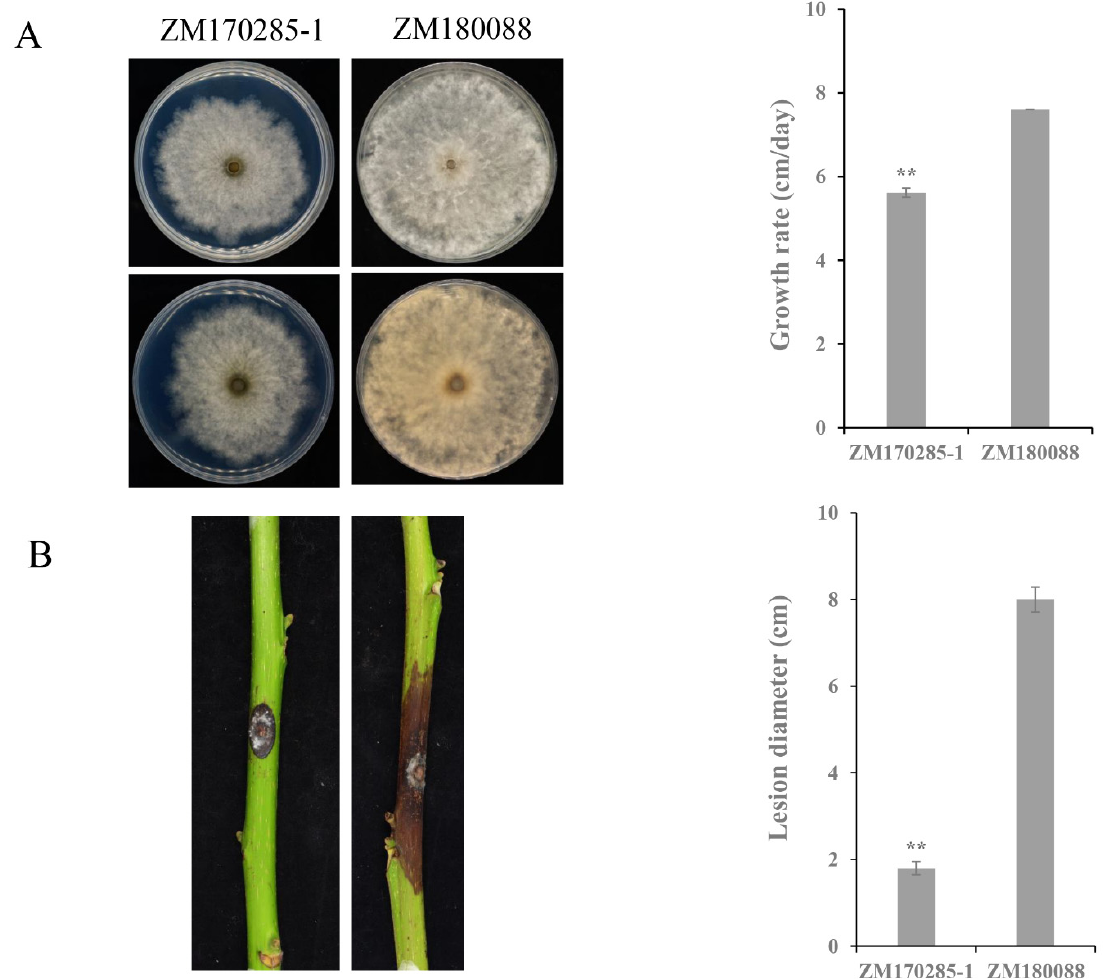
Figure 3. Biological characteristic comparison between strains ZM170285-1 and ZM180088. ( A ) Col- Biological characteristic comparison between strains ZM170285-1 and ony morphology and growth rates of strains ZM170285-1 and ZM180088 grown at 25 °C for 3 days on PDA medium. ( B ) Pathogenicity assay and lesion diameters of two strains grown on detached walnut stems at 10 days post inoculation at 30 °C, and approximately 90% relative humidity. **, indicates a significant difference ( p < 0.01) between strains ZM170285-1 and ZM180088.